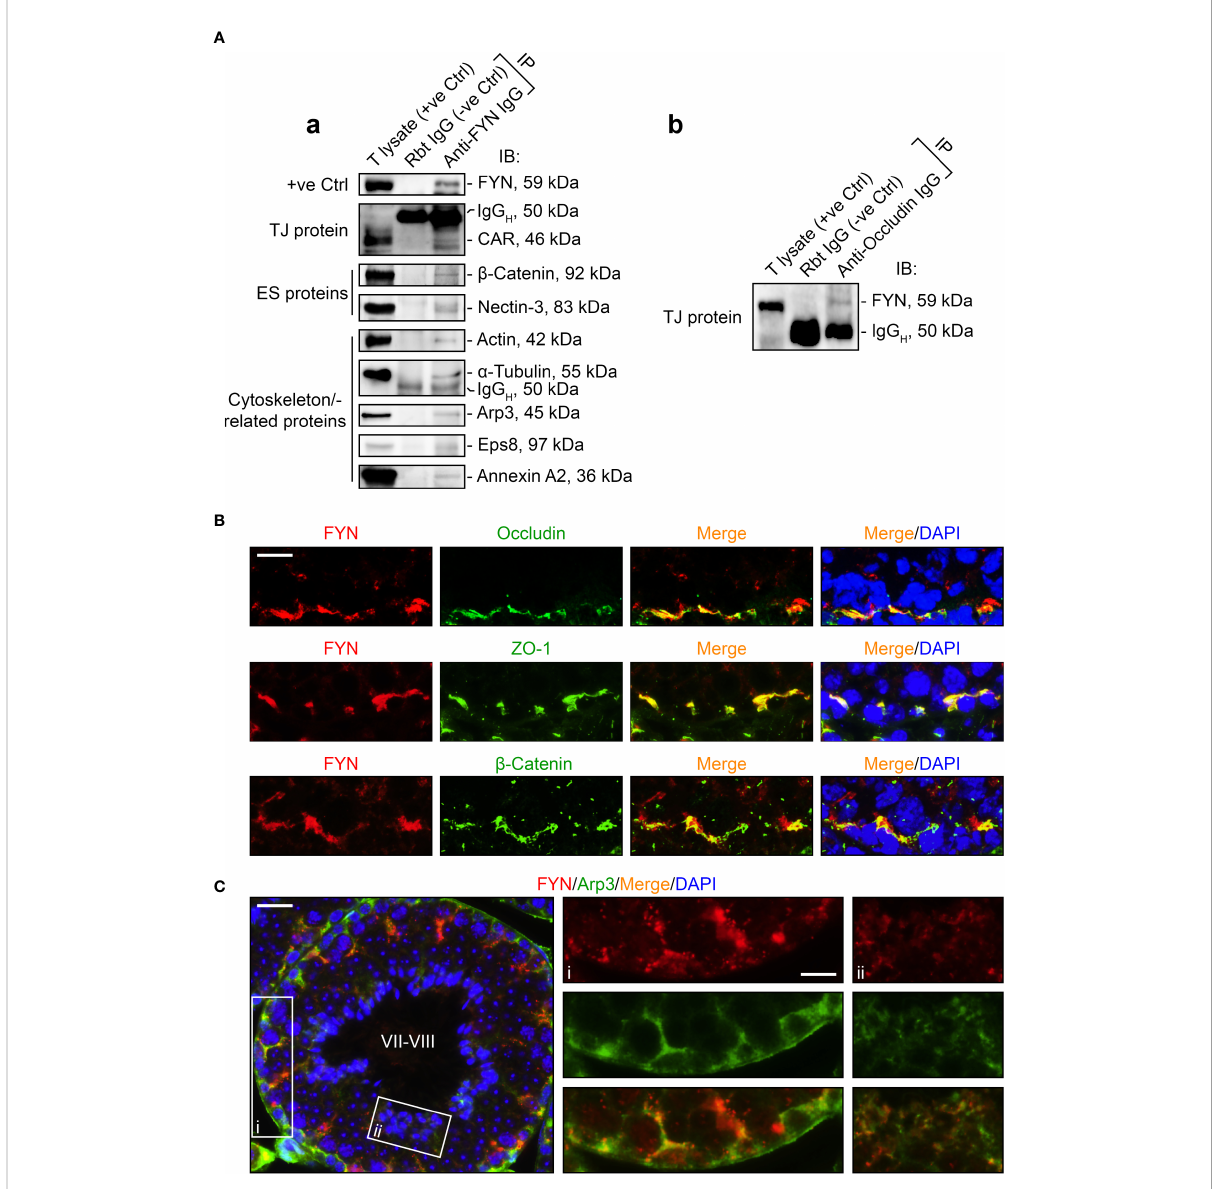
FIGURE 3 FYN is an integral component of the BTB and apical ES as demonstrated by Co-IP and dual-labeled IF assays. (A) Co-IP assays to determine the physical interactions between FYN and selected BTB/apical ES-associated proteins [including TJ proteins CAR (A, a) and occluding (A, b) , basal ES protein b -catenin, apical ES protein nectin-3, as well as cytoskeletal proteins actin, a -tubulin, Arp3, Eps8, and annexin A2] using mouse testis (T) lysates (~800 µg total protein/sample). A positive control (+ve Ctrl) was either testis lysate (30-50 µg protein/lane) without Co-IP, or the immunoprecipitated FYN was detected using its own antibody by immunoblotting (A, a) . For the negative control (-ve Ctrl), anti-FYN IgG was replaced with rabbit (Rbt) IgG. Several immunoblots show the heavy (IgG H ) and light (IgG L ) chains of IgG to better illustrate Co-IP results. (B) Dual-labeled IF staining to corroborate FYN localization at the BTB by its co-distribution with TJ proteins occludin and ZO-1, as well as basal ES protein b -Catenin in the testis. Scale bar, 10 m m. (C) FYN co-localization with actin binding protein Arp3, a key regulator of branched actin nucleation at the BTB and apical ES, further substantiated its presence at the BTB and apical ES (45). The stage of the seminiferous epithelium is indicated in Roman numerals. Scale bar, 16 m m. Boxed areas denoted with i and ii (showing FYN-Arp3 co-localization at the BTB and apical ES, respectively) are enlarged and presented to the right in the second and third columns, respectively (Scale bar, 8 m